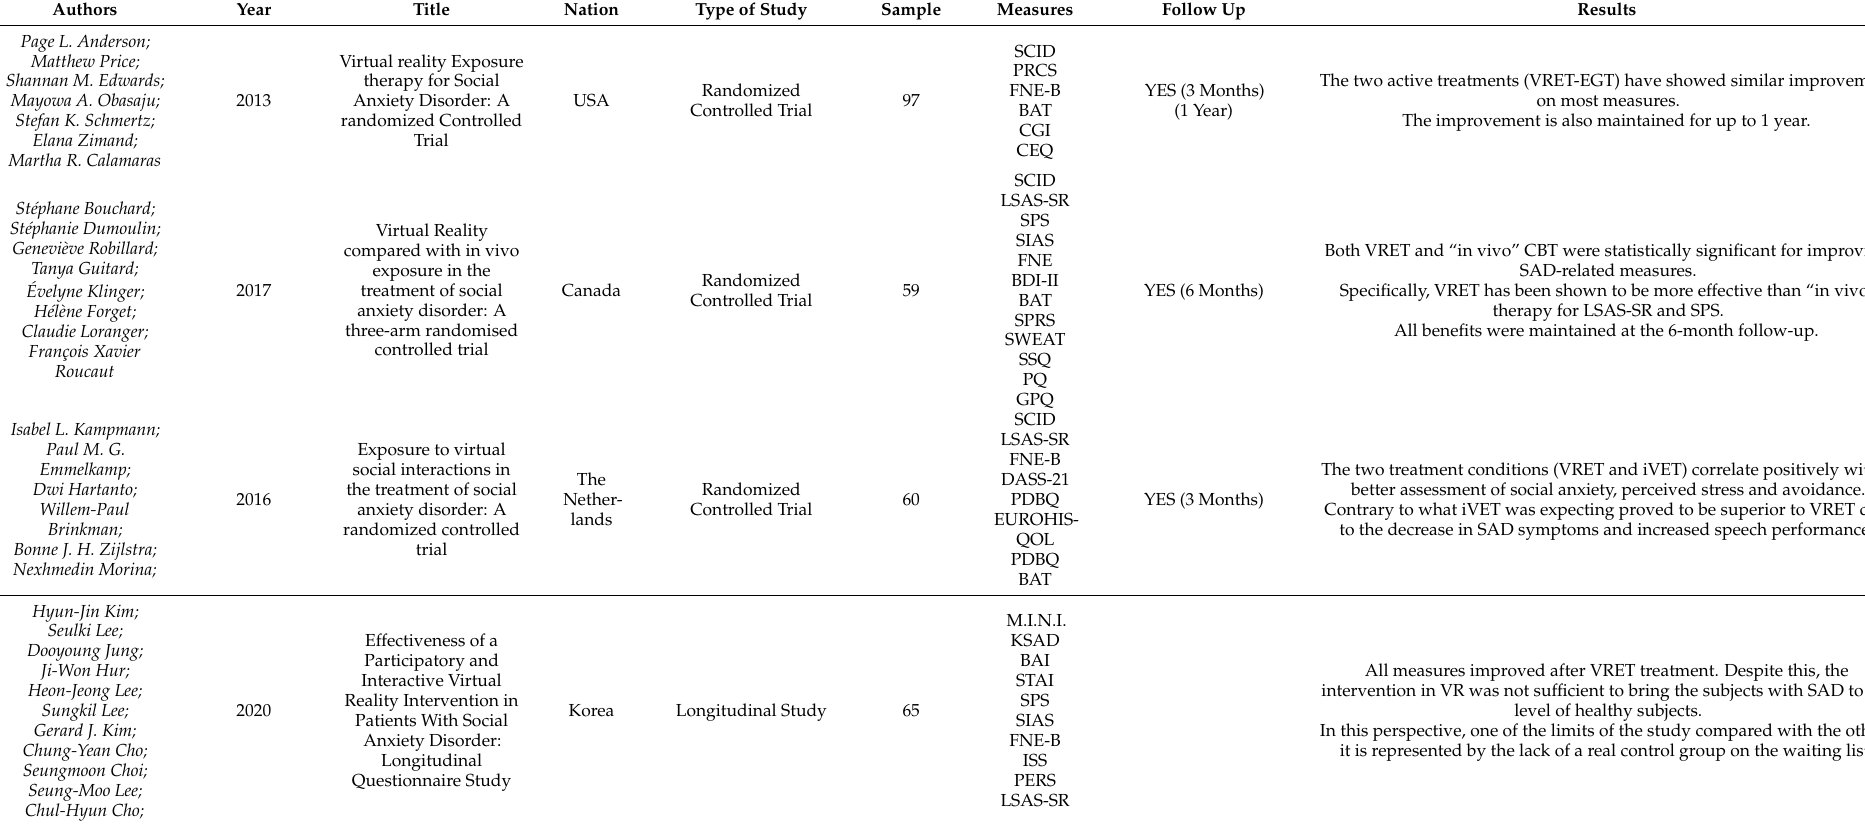
Table 1. Data Extraction. Authors included in the table in alphabetical order starting from the first